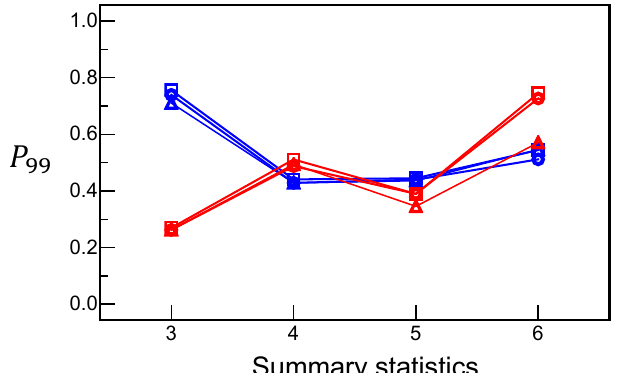
Figure 11: 99%-percentiles of the distance-distributions of the parameter regressors achieved within ABC for ENCA (blue) and INCA (red), as a function of the total number of used statistics, for model (13). Circles, squares and triangles correspond to the regressors for α , δ , and ε , respectively. Latent spaces of dimension 4 and 5 yield the most accurate posterior for ENCA (Fig. 9), whereas for INCA 5 summary statistics lead to the best result (Fig. 10). The full distributions are shown in the Appendix.